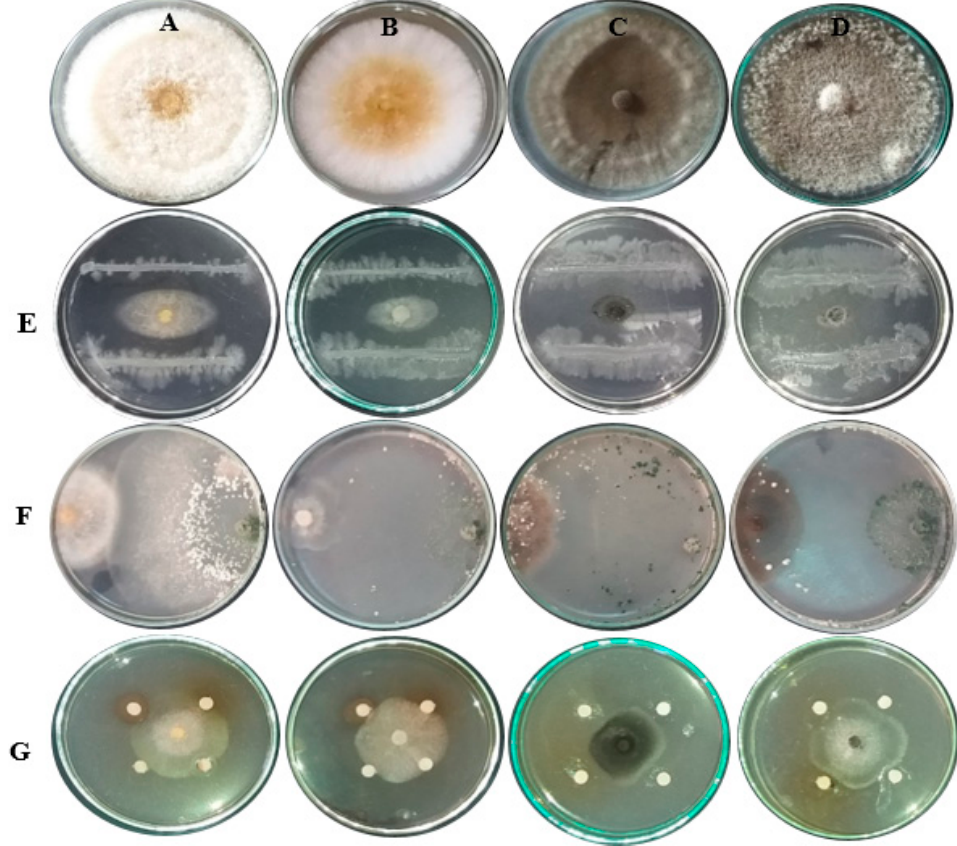
Figure 4. Visual observations of the antifungal activity of P. fluorescens ( E ), T. viride ( F ) and C. sinensis LE ( G ), against F. solani ( A ), F. oxysporum ( B ), E. rostratum ( C ) and N. lacticolonia ( D ).